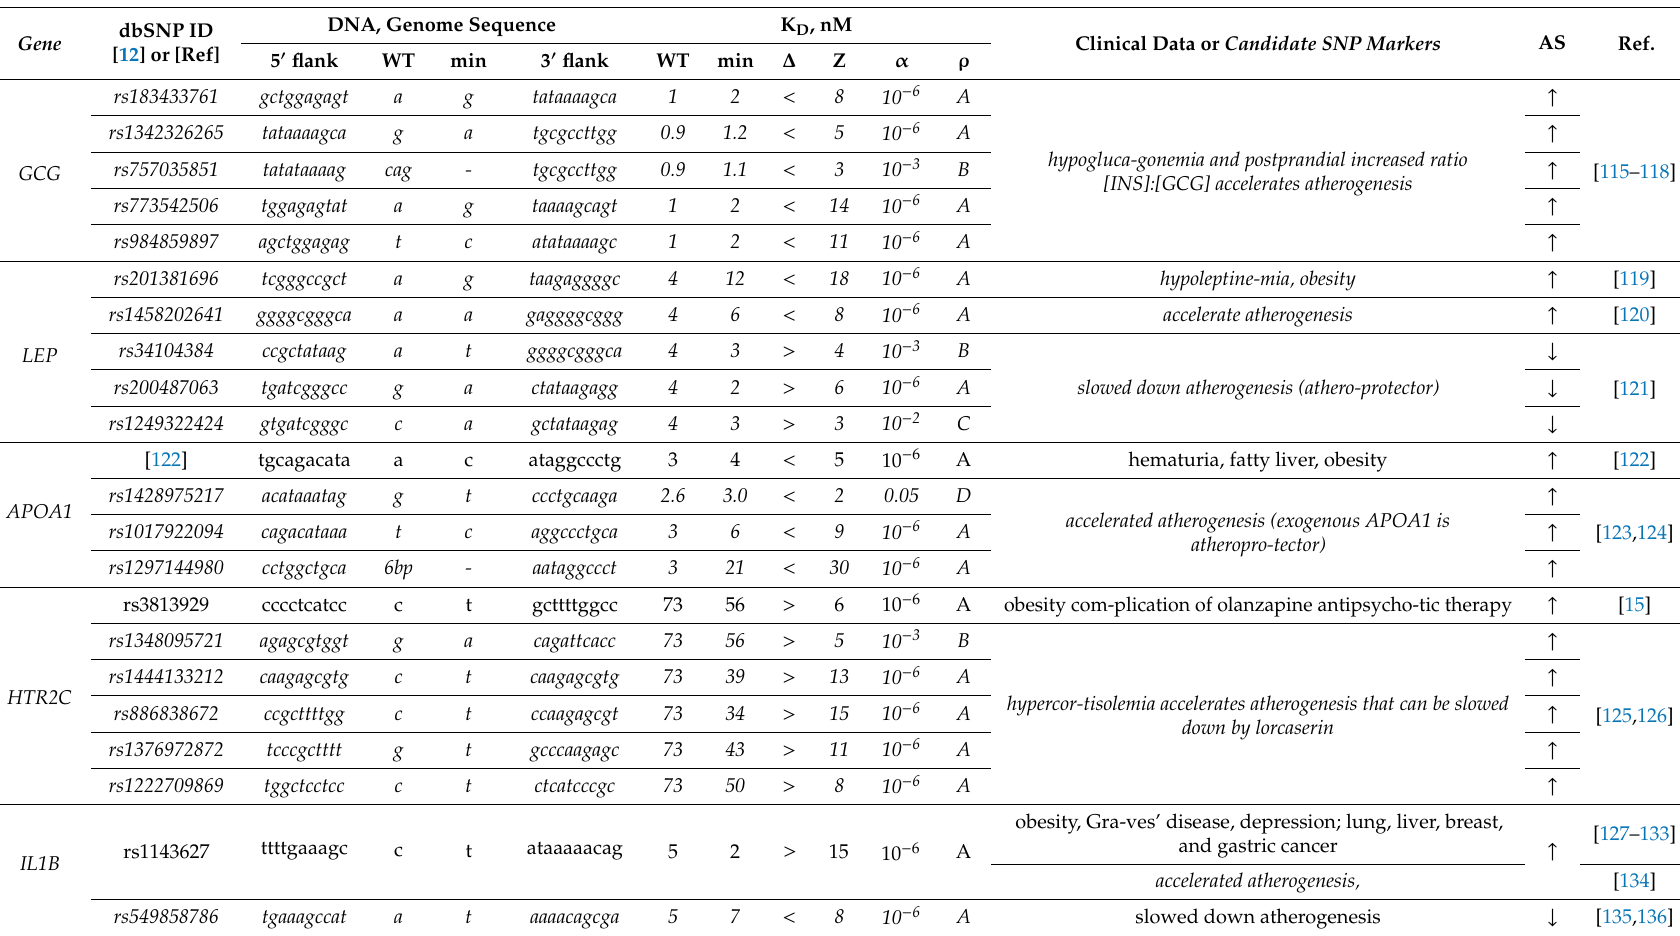
Table 5. Atherogenesis-related candidate SNP markers within the gene promoters where SNPs of TBP-sites are clinically linked with obesity.